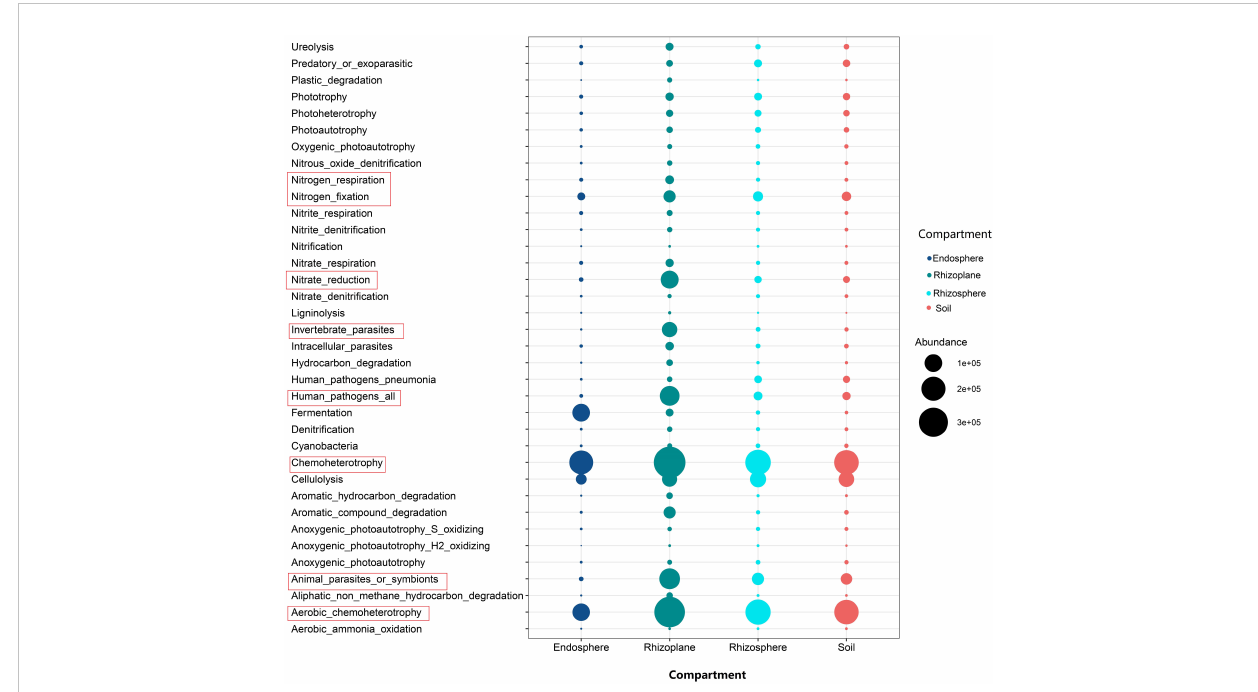
FIGURE 5 The bubble chart showing the abundance of functional gene of bacteria inferred by Functional Annotation of Prokaryotic Taxa for different compartments of the rubber tree